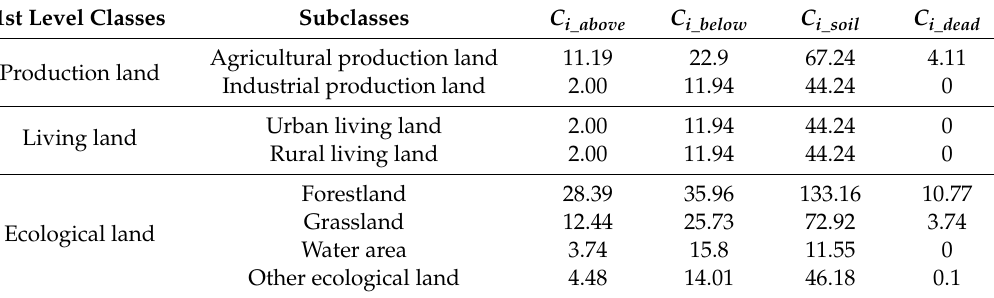
Table 2. Carbon density of each land use type (unit: Mg C / hm 2